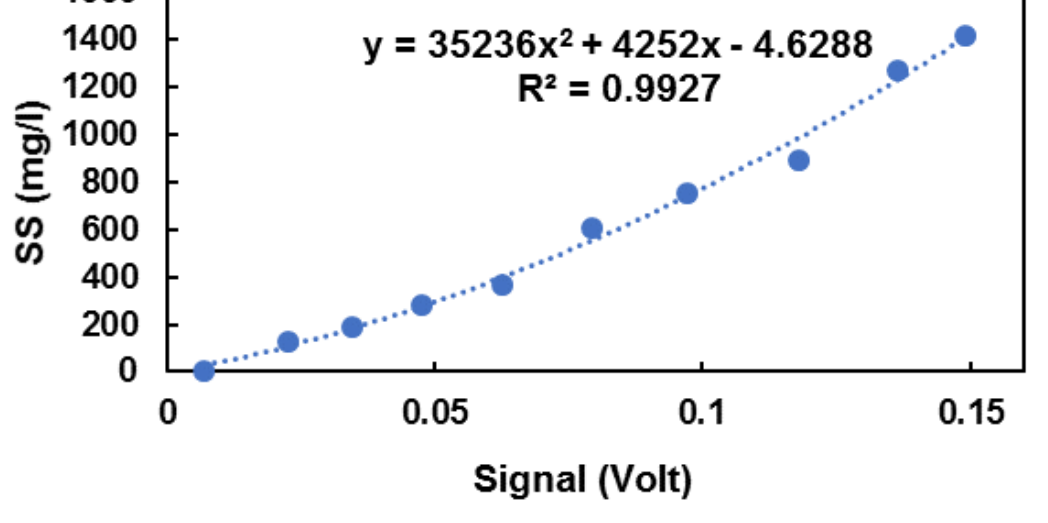
Figure A1. An example of a calibration curve: upstream of Basin B2 (for high range of voltage). Points correspond to the samples collected during the calibration process